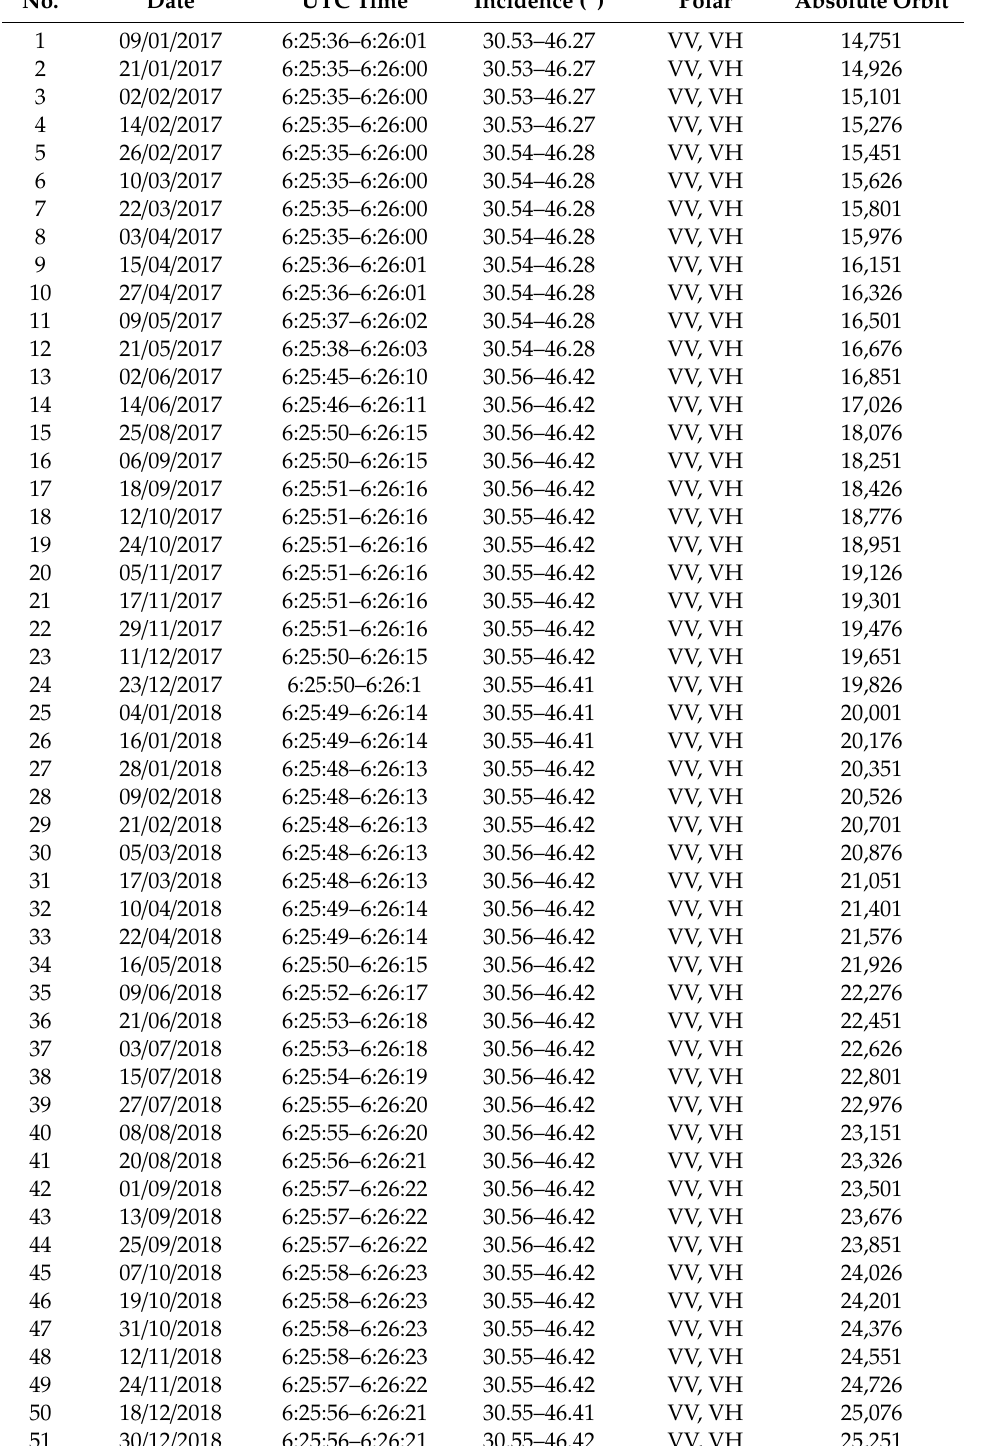
Table A1. Acquisition information for the Sentinel-1A